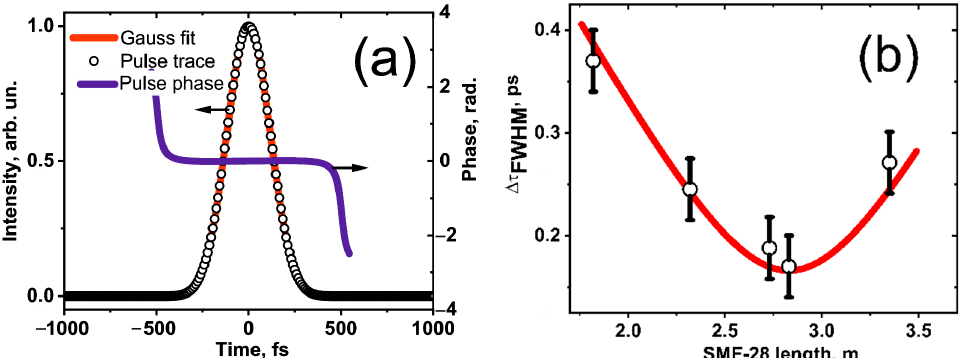
Figure 8. ( a ) Autocorrelation trace of USP and Gaussian fitting, along with the pulse phase. ( b ) Pulse width vs. length of output SMF-28 fiber. width vs. length of output SMF-28